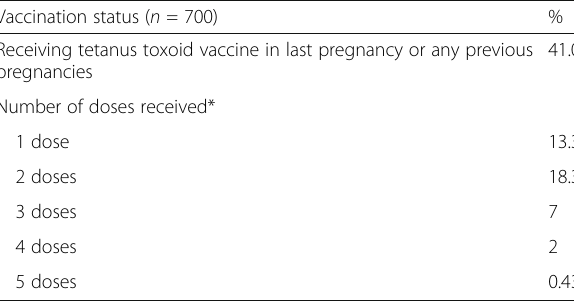
Table 4 Vaccination status of reproductive-age women